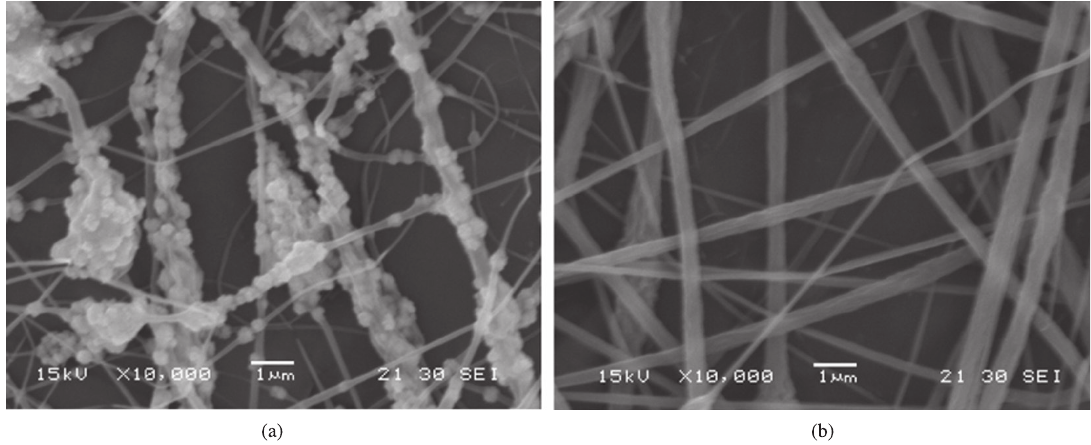
Figure 5. SEM images of a) EC/THF/DMF 20/80; voltage : 13 kV; flow rate : 0.2-0.4 mL/h; distance : 10 cm; BT content: 29,5% wt., b) without